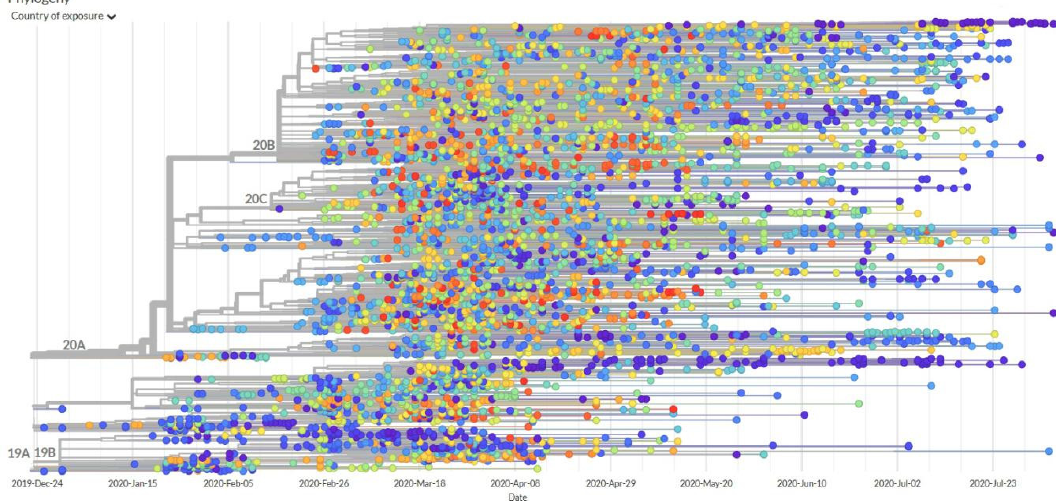
Figure 5. Nextstrain platform analysis of new coronavirus transmission genome [39].